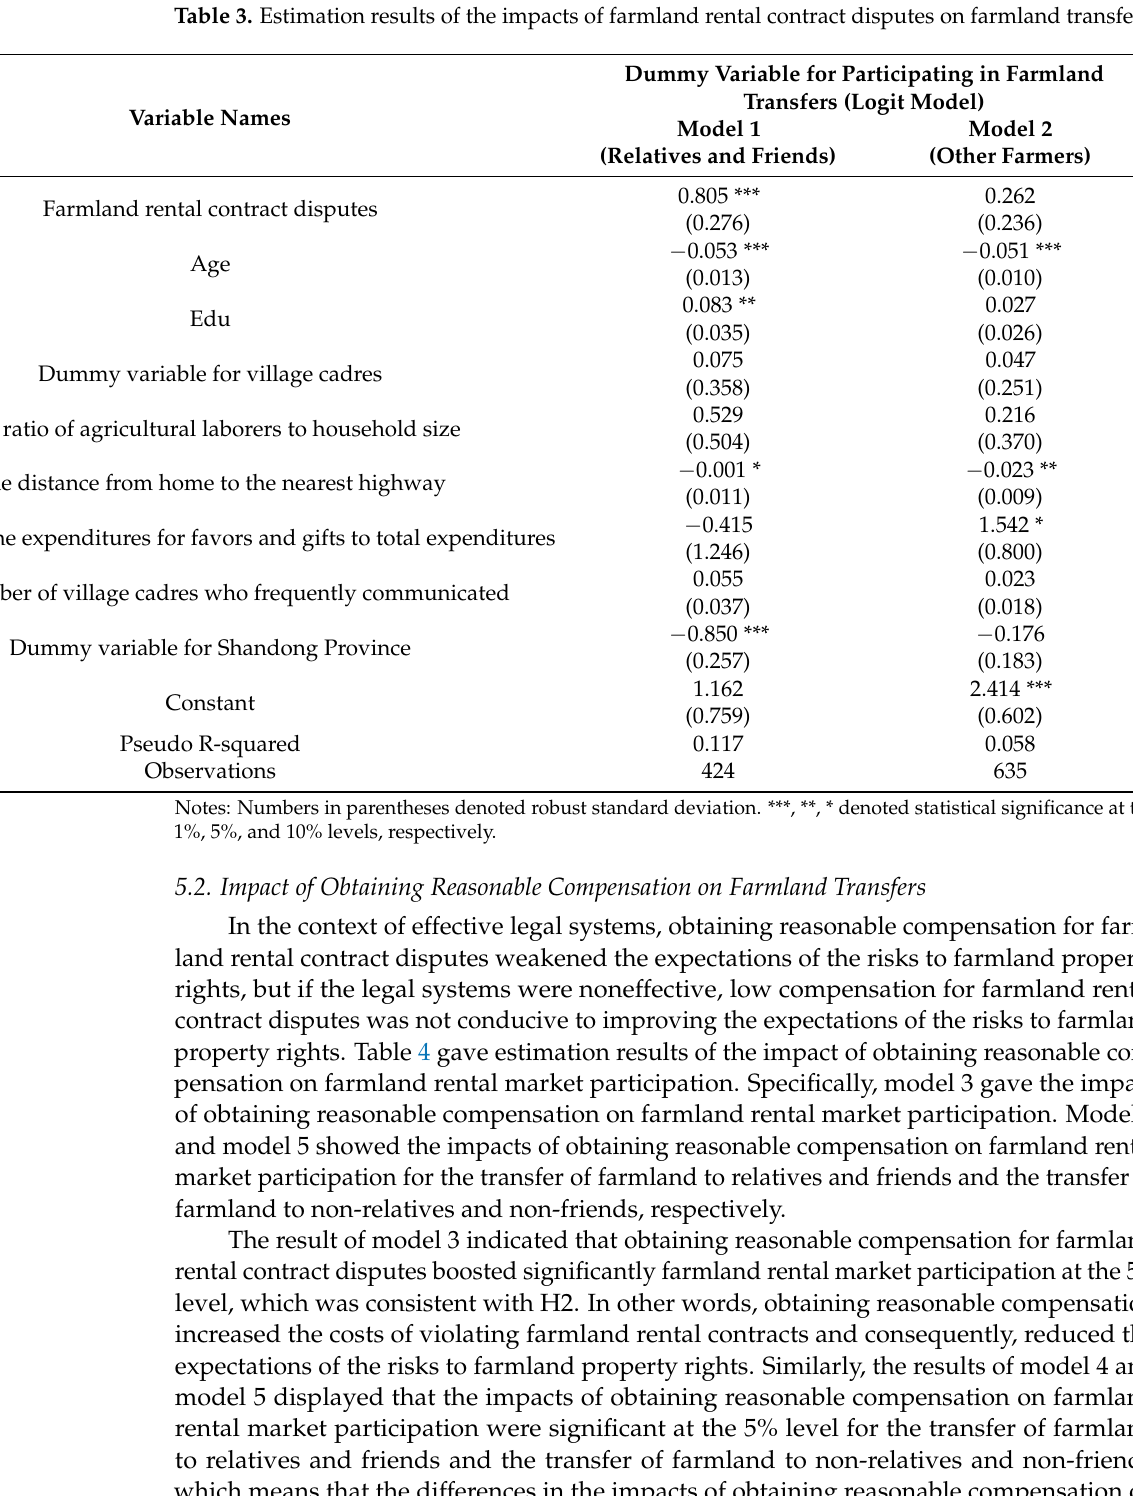
Table 3. Estimation results of the impacts of farmland rental contract disputes on farmland